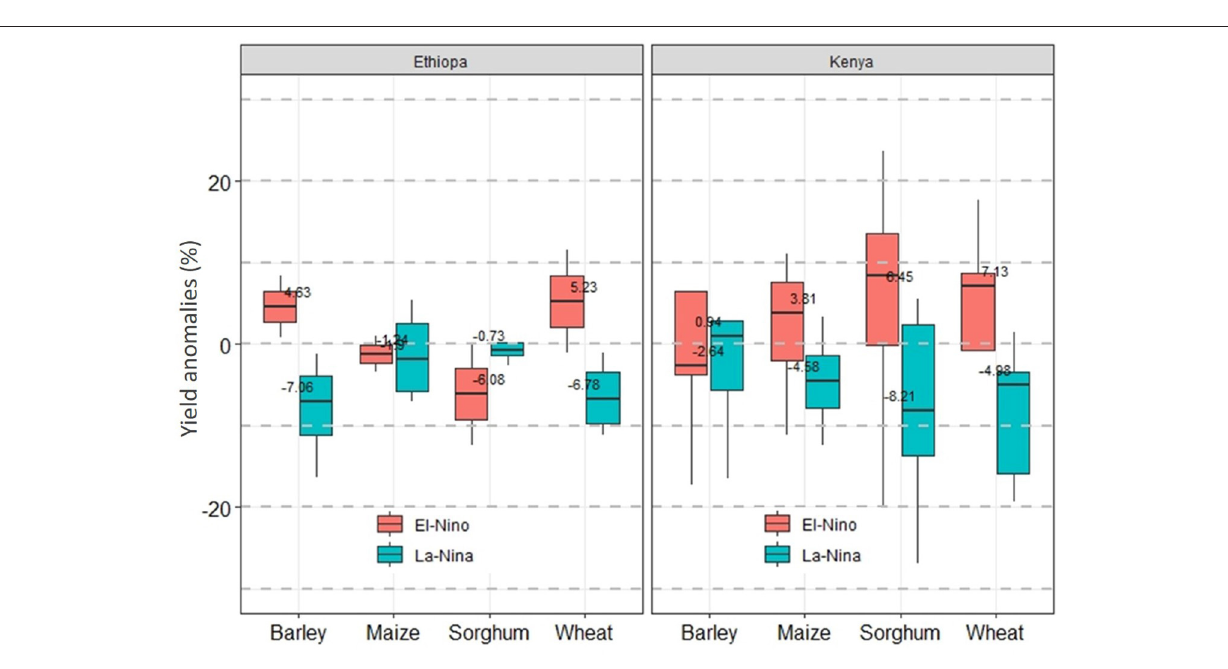
FIGURE 6 | Box plots showing 0, 25, 50, 75, and 100th percentiles, and means (solid line) of yield anomalies for major crops in Eastern Africa during El Niño and La Niña